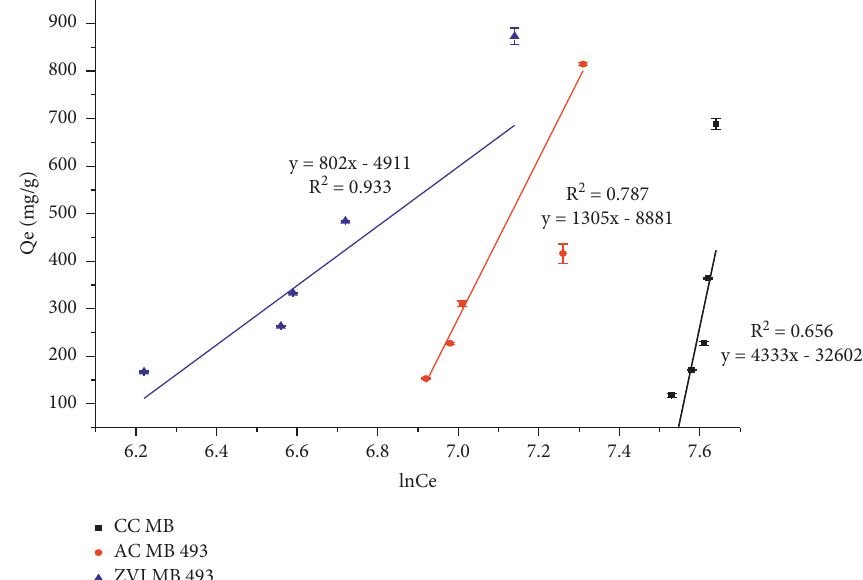
Figure 10: Temkin adsorption isotherm for removal of β -carotene onto CC MB, AC MB 493, and ZVI MB 493 at 75 ° C.